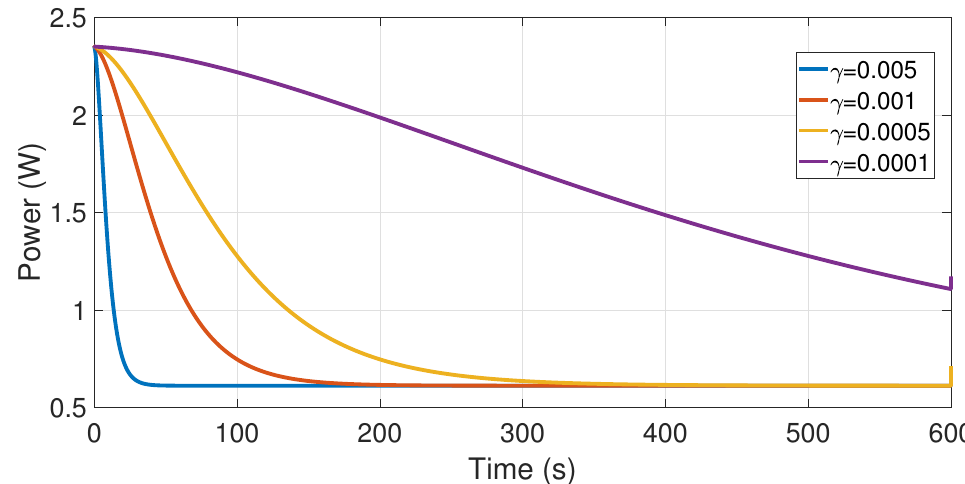
Figure 10. Simulation of power stability with different values γ